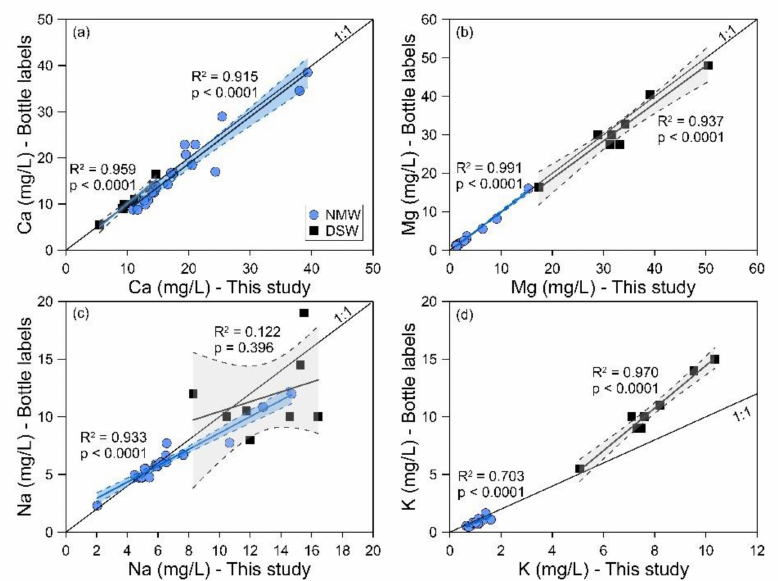
Figure 2. Comparison of major cation concentrations measured in this study and those on bottle label: ( a ) Ca, ( b ) Mg, ( c ) Na, and ( d ) K. The regression lines for NMW and DMW are superimposed within the range of 95% confidence